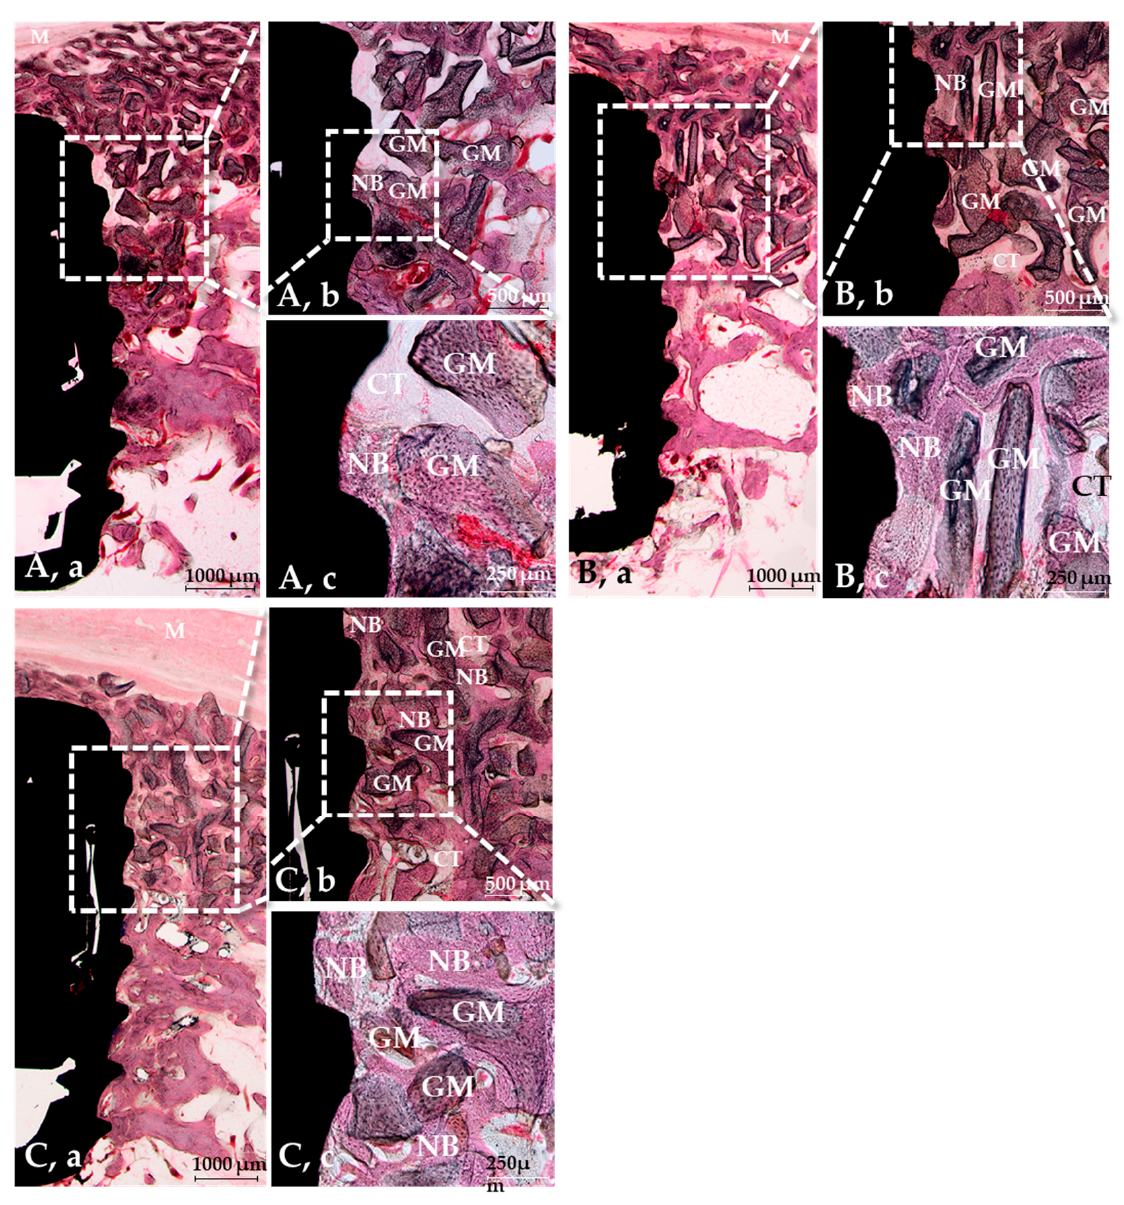
Figure 7. H&E stained sections at 8 weeks post-implantation. ( A ) The SLA group, ( B ) the GA group, ( C ) the GR group, ( a ) × 12.5, ( b ) × 40, ( c ) × 100. Note: NB = New bone, GM = Bone graft material, CT = Connective tissue, M = Membrane.